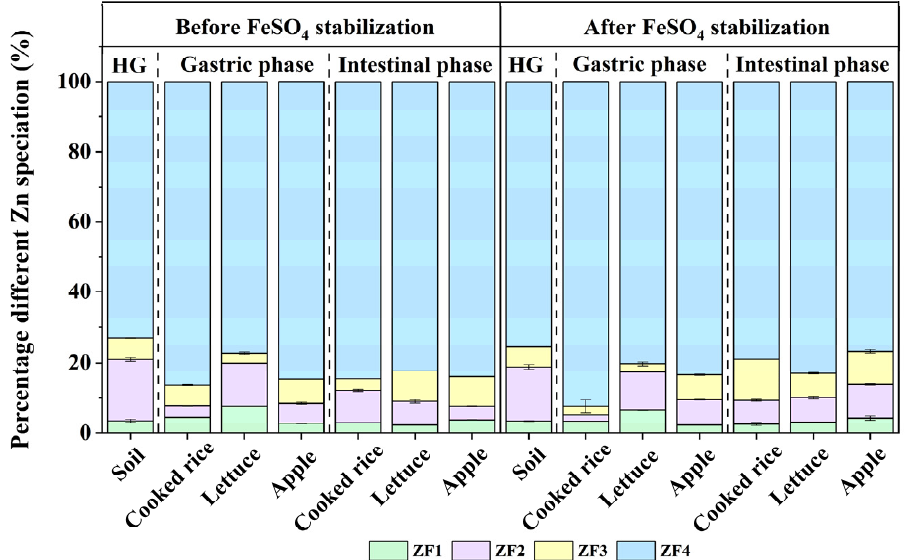
Figure 5. Transformation of Zn in the gastric and intestinal phases after addition of different dietary components before and after FeSO 4 stabilization. Data are presented as the mean ± standard deviation (S.D.) of the three experimental groups. ANOVA analysis reveals the statistical differences between the stabilization treatments and dietary addition groups of different Zn fractions. Summary of statistical information including p values is given in Table S5. HG: original soil, ZF1: acid-exchangeable Zn, ZF2: reducible Zn, ZF3: oxidizable Zn, ZF4: residual Zn.